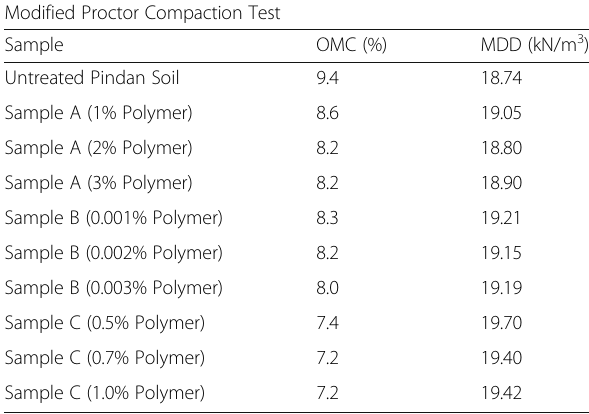
Table 5 Optimum Moisture Contents (OMC) and Maximum Dry Density (MDD) of Broome-Pindan Soil and Mixtures